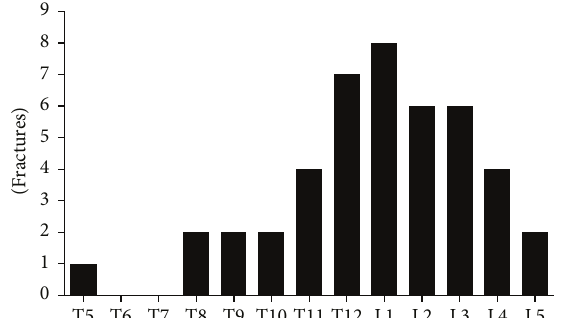
Figure 3: Fracture levels detected using MRI. The most common level was the L1 vertebra, followed by T12, L2, and L3.